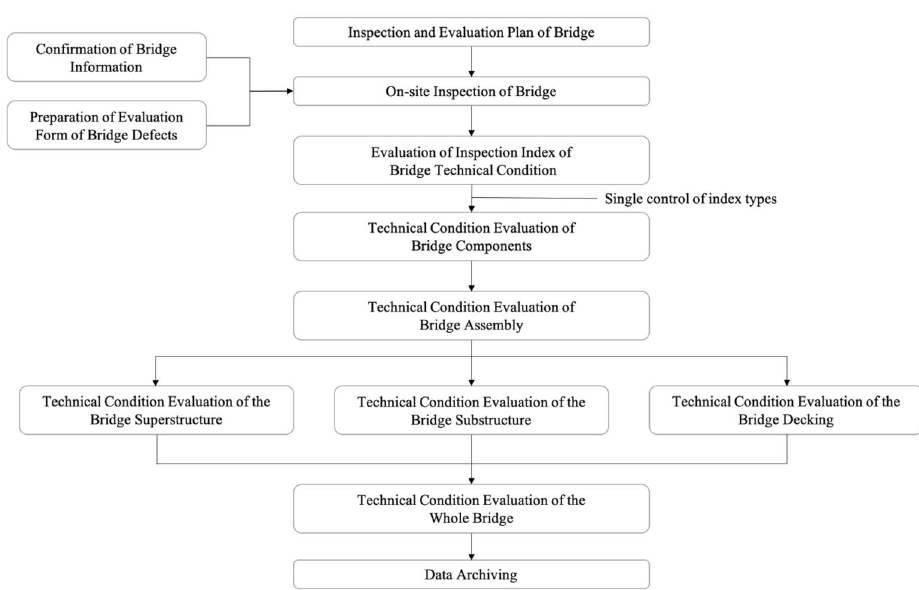
Figure 5. Workflow of bridge technical condition